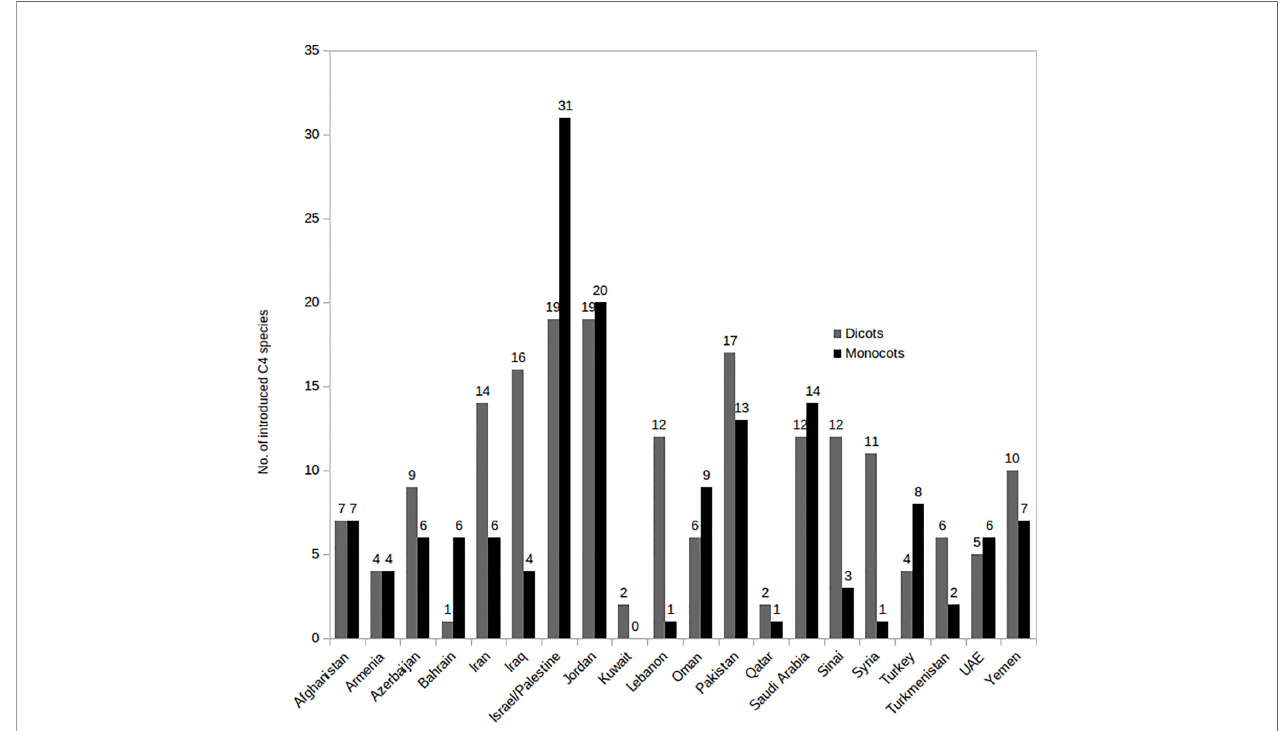
FIGURE 3 | Distribution of introduced C 4 Monocots and Eudicots per country in various Southwest (SW) Asian countries.